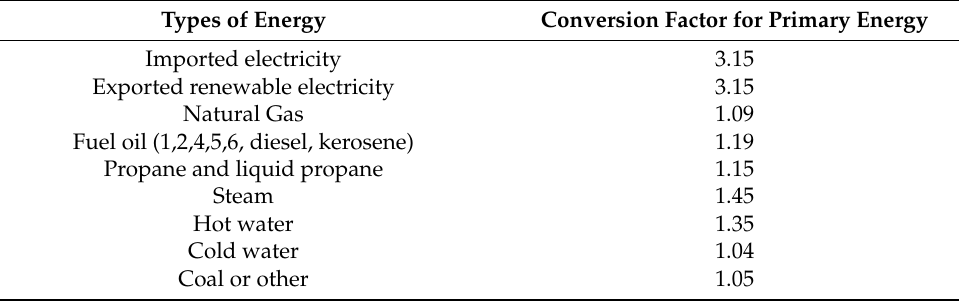
Table 6. Factors for conversion to primary energy. Data obtained from ASHRAE 105